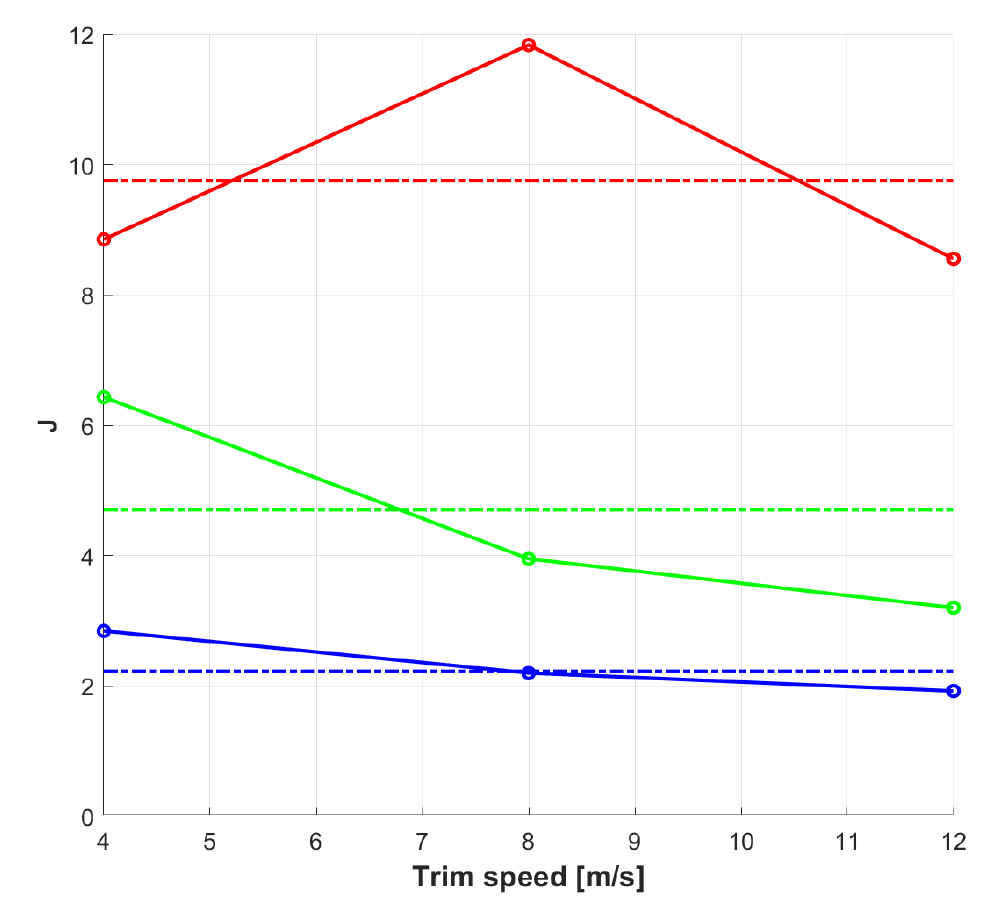
Figure 13. Optimal cost function for optimizations at different airspeeds (continuous line), and for global optimizations on all airspeeds (dash-dotted horizontal line). Red: layout (A). Green: layout (B). Blue: layout (C).